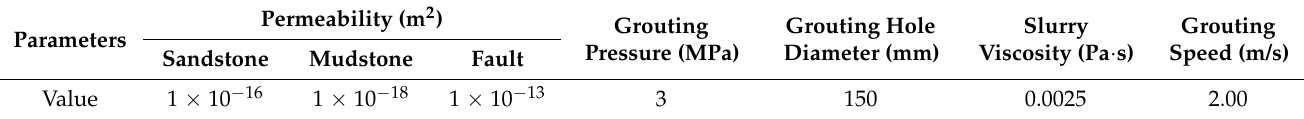
Table 1. Parameters for the small bed separation numerical model.